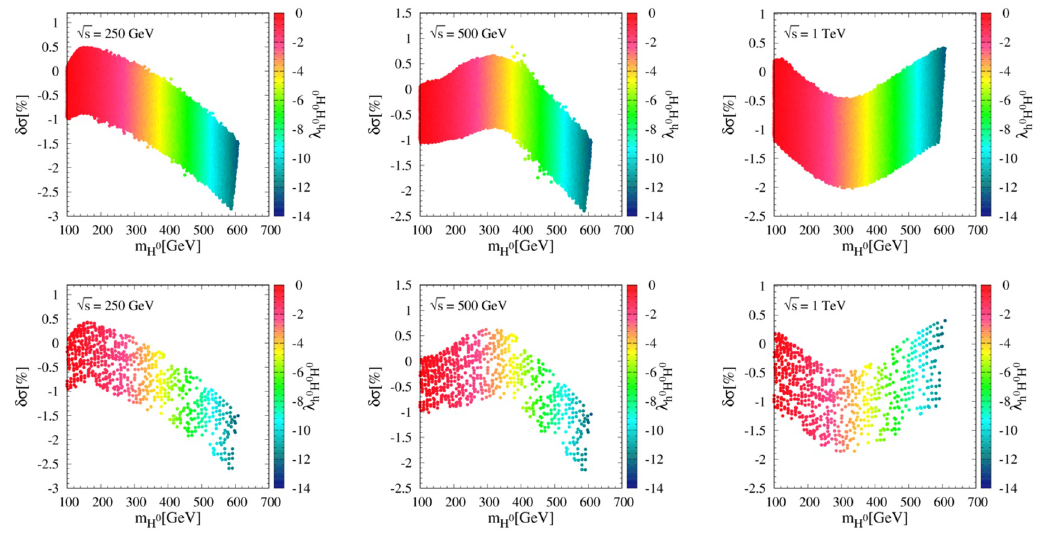
Figure 11 . IHDM corrections to e + e − → Zh 0 as a function of the Higgs masses are shown for Scenario IV and Scenario V, where the condition of Br ( h 0 → A 0 A 0 ) ≤ 11% is imposed. The upper panel is for Scenario IV, and the lower one is for Scenario